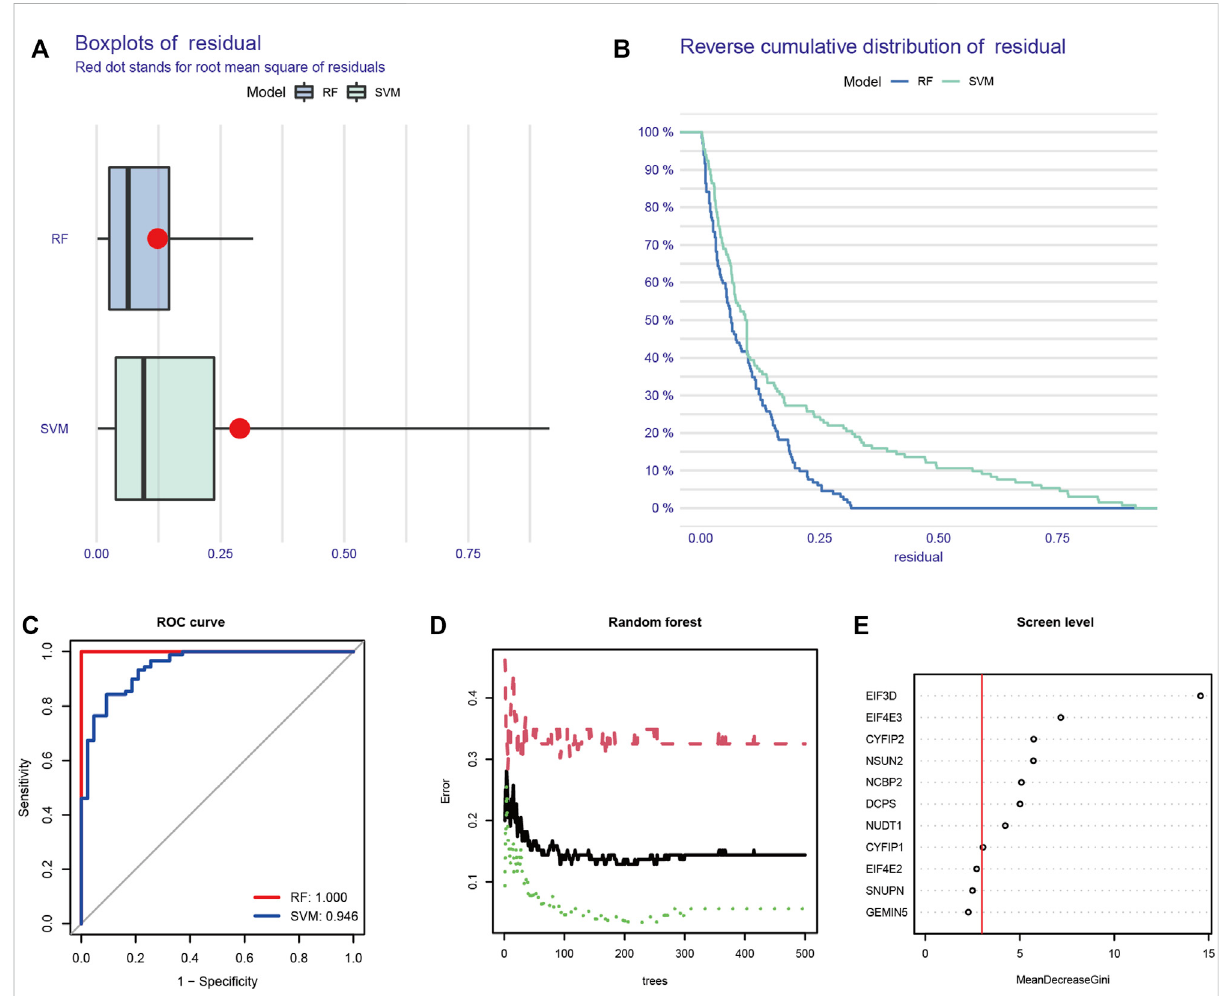
FIGURE 2 Machine learning screens m7G key regulatory genes. (A) Boxplot of residual in RF and SVM. (B) Reverse cumulative distribution of residual in RF and SVM. (C) ROC curve of RF and SVM. (D) Random forest screening of DEGs. (E) Screening for candidate m7G-regulated genes by RF. RF: random forest; SVM: support vector machine; ROC: receiver operating characteristic; DEGs: differentially expressed